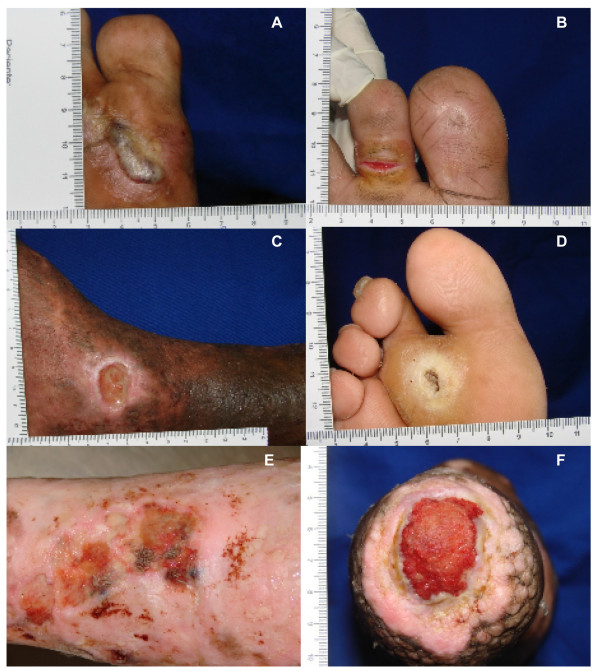
Examples of ulcers in patients with leprosy. (A) Blister formed after walking long distances that later became an ulcer. (B) Fissure on the base of the second toe of the right foot. (C) Right medial malleolus ulcer from a patient with leprosy and HBP. (D) Plantar ulcer on the region of second metatarsal head. (E) Myiasis in a chronic leg ulcer. (F) Chronic ulcer on a lower limb stump.